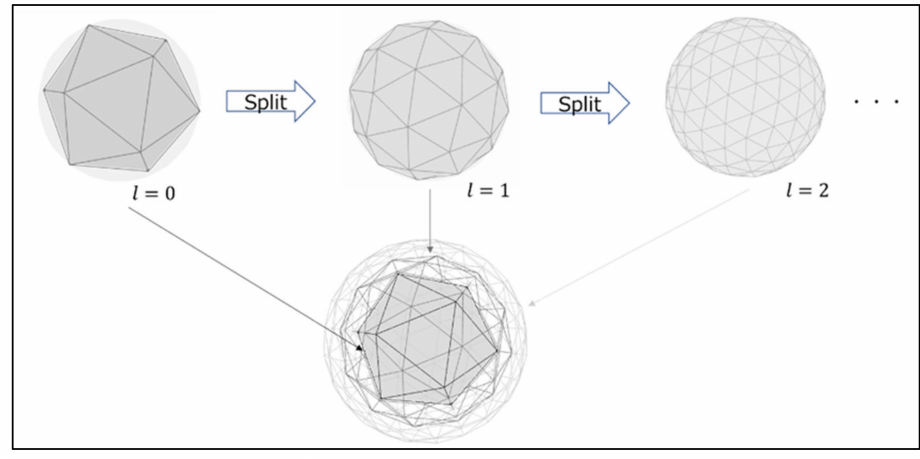
Figure 5. Layers of the S-TS-SOM.